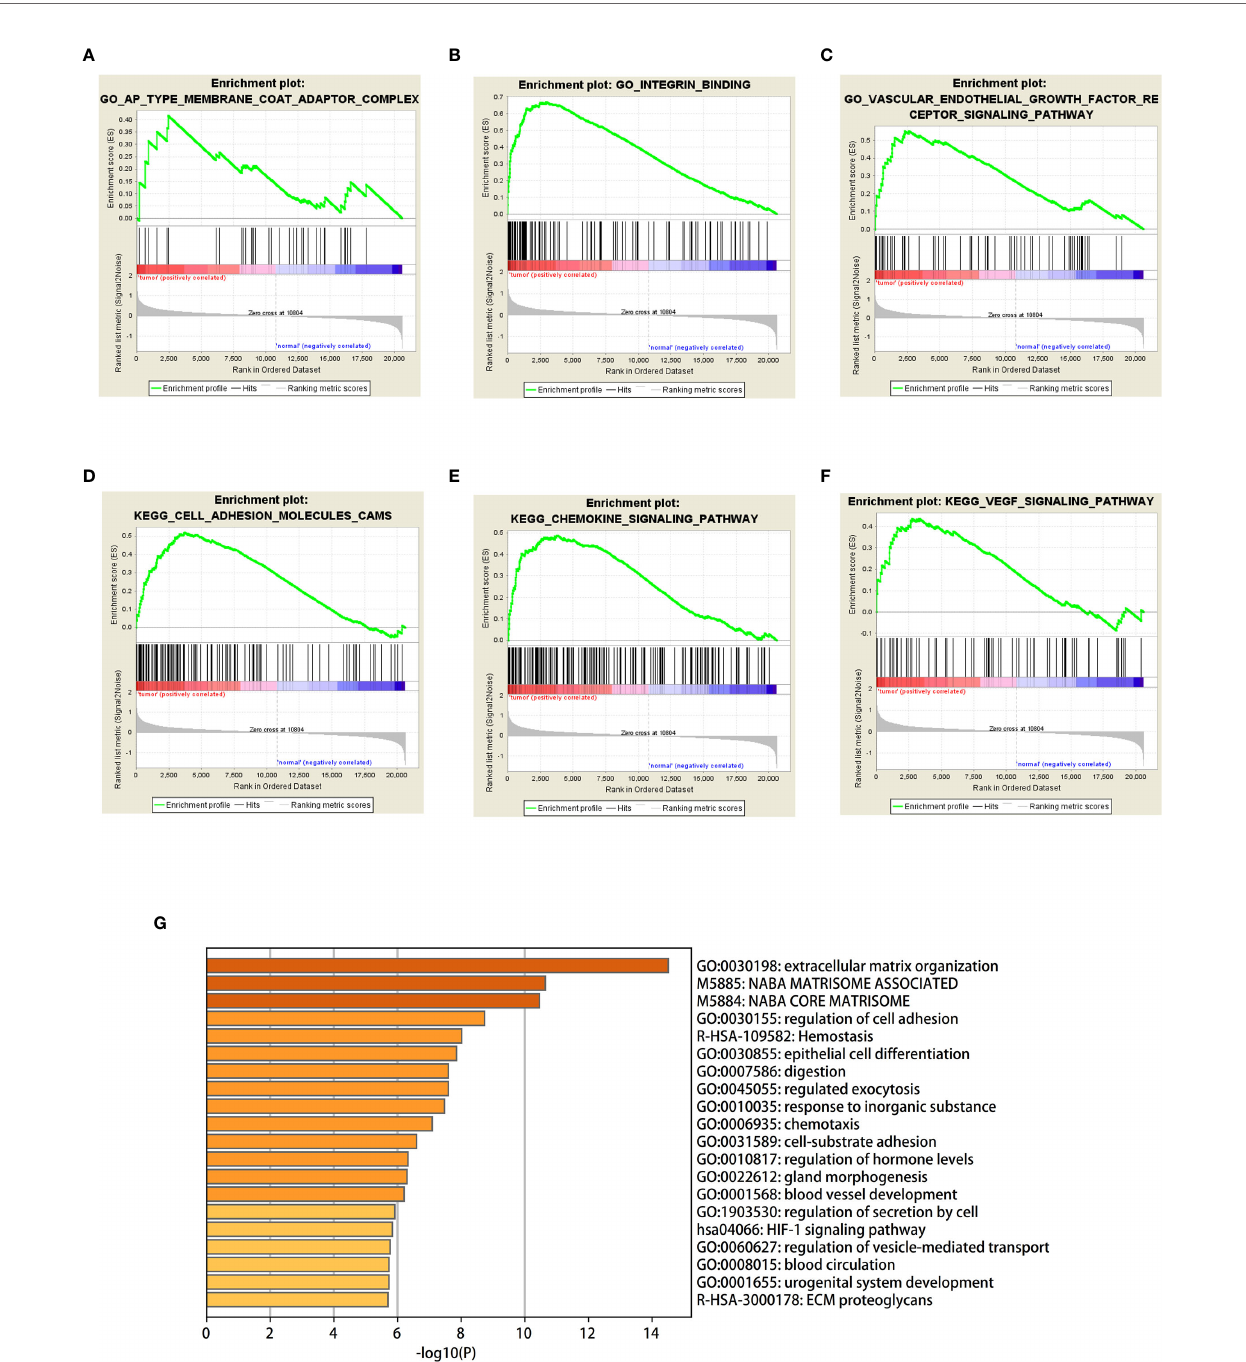
FIGURE 6 | (A – F) Based on gene set enrichment analysis (GSEA), the main GO term and signaling pathway of differentially enriched genes in gastric cancer tissues and normal tissues were investigated. (G) Bar graph of enriched terms across input gene lists, colored by